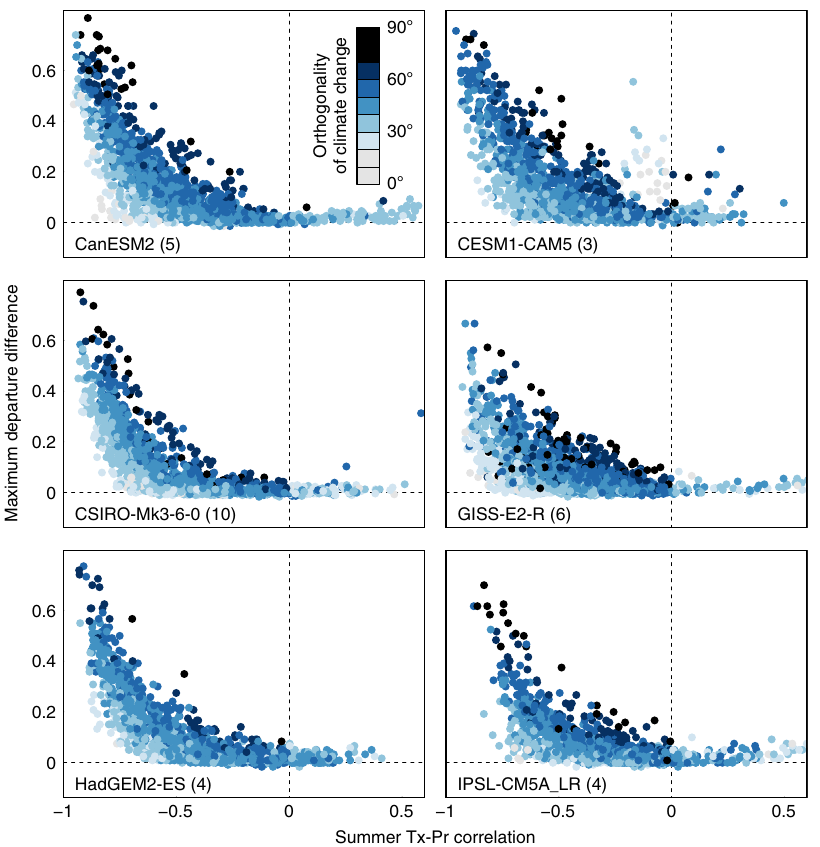
Fig. 4 Relationship of departure intensi fi cation to temperature-precipitation correlations and the orthogonality of climate change in six CMIP5 models. Orthogonality increases departure intensi fi cation at any given correlation. However, substantial departure intensi fi cation is only present at temperature- precipitation correlations stronger than r = − 0.5. Departure intensi fi cation, measured as maximum departure difference, is calculated from the mean time series of univariate and bivariate 2 σ proportions of historical+RCP4.5 runs for each CMIP5 model. The correlation between summer mean daily maximum temperature (Tx) and precipitation (Pr) in each CMIP5 model is calculated from the r1i1p1 historicalNat run, typically for the years 1850 – 2006. The orthogonality of climate change ( θ ) is the angular displacement of the RCP4.5 single-model ensemble mean projected normals for the 2051 – 2100 period from the dominant axis of bivariate interannual variability. The number of runs in each ensemble is indicated in parentheses next to the model name. Oceans and Antarctica are not plotted. A random sample of n = 1500 grid cells is plotted for each model to equalize plotting density. Dashed lines indicate a value of zero in the x - and y -axis